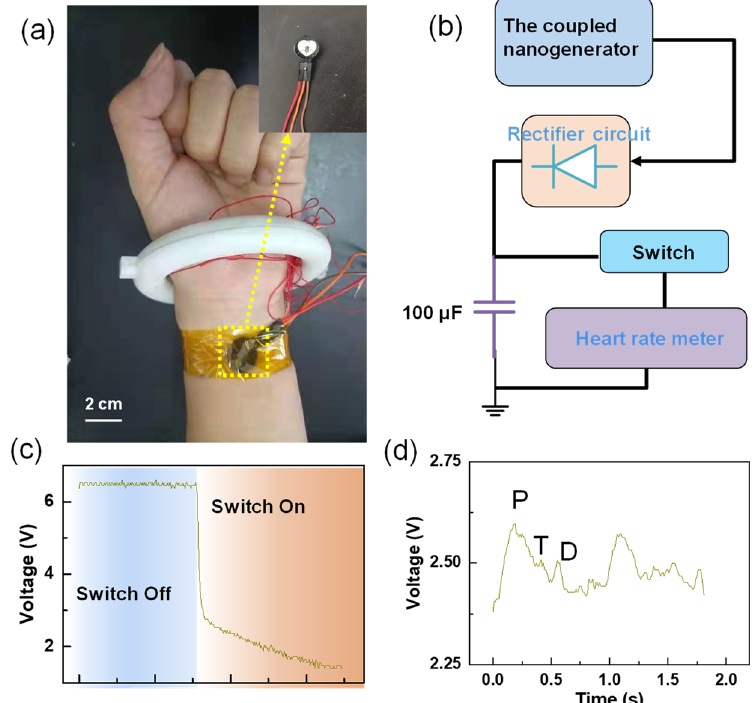
Figure 7. Self-powered heart rate testing system: ( a ) the electronic photo of system; ( b ) the block diagram of system composition; ( c ) the voltage changed at both ends of the capacitor before and after fast closing. After the switch was closed, the electric quantity in the capacitor began to power the heart rate sensor, and the voltage dropped sharply); and ( d ) pulse waveform collected.